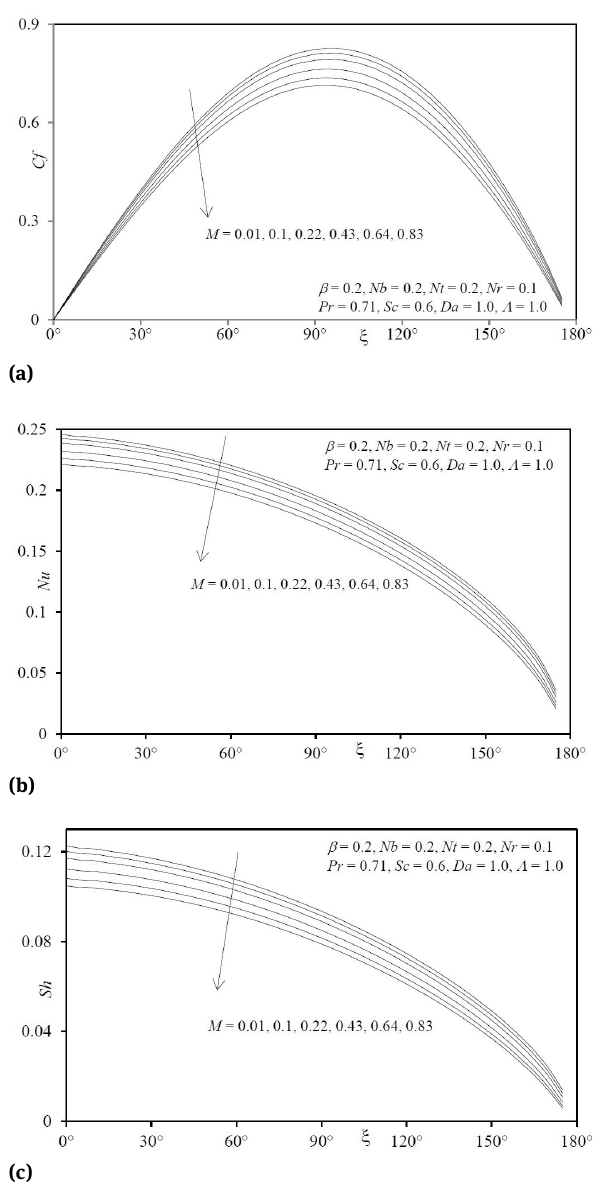
Fig. 12: (a) Influence of M on Skin Friction; (b) Influence of M on Nusselt Number; (c) Influence of M on Sherwood Number